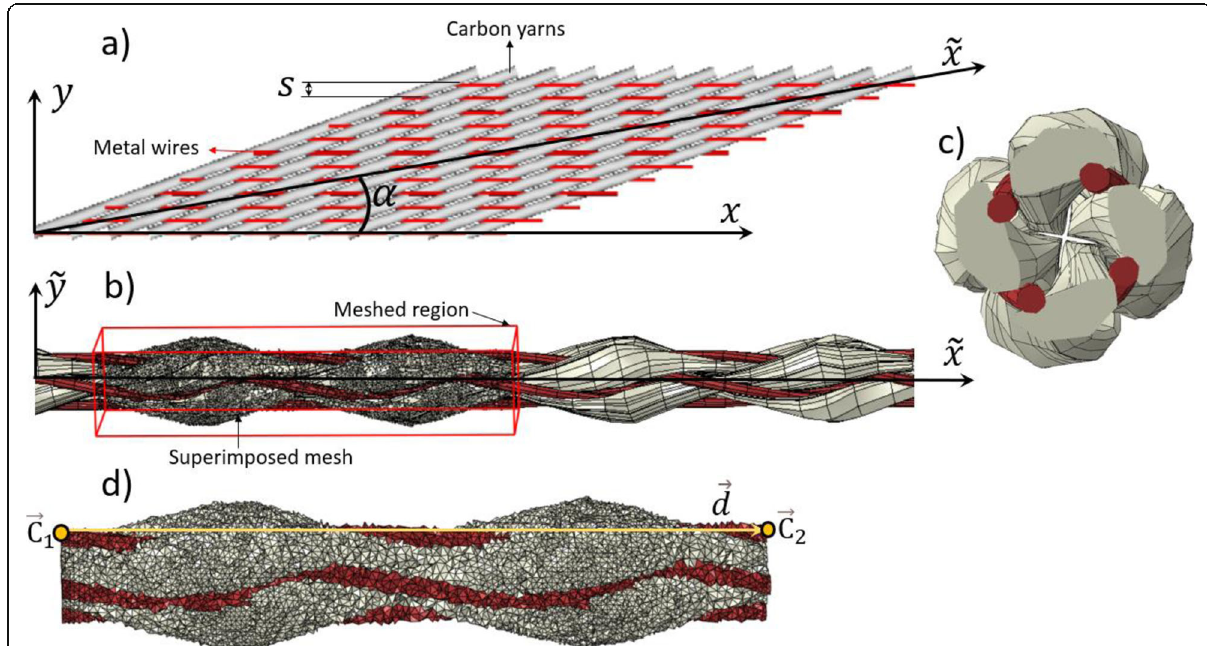
Fig. 6 Data flow for creating FE model of braided thread: a geometrical model of flat textile produced with WiseTex software [43], b solid model of thread created by geometrical transformation of the flat model with superimposed image of the mesh, c cross-section of the braid model after the “ rolling ” transformation, d voxel-like mesh of the reinforcement showing periodicity vector d